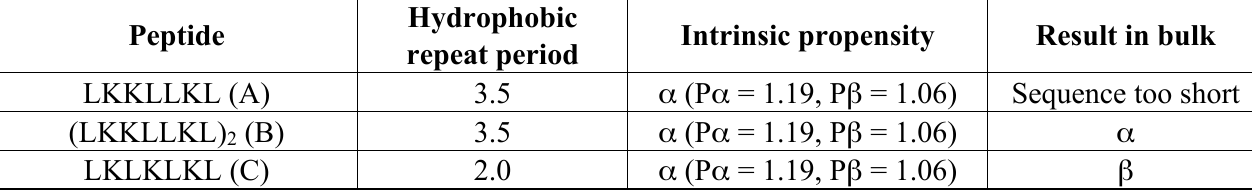
Table 2. Peptide sequence with hydrophobic periodicities, intrinsic propensity of the sequence and the observed conformation in